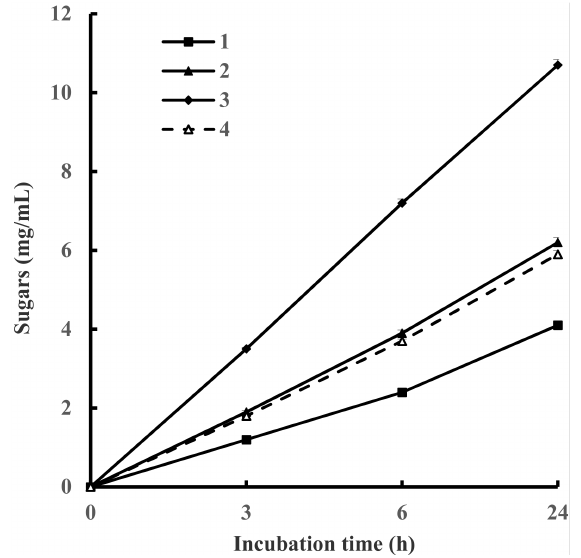
Figure 3. Accumulation of reducing sugars during hydrolysis of pretreated wheat straw (WS) using I. lacteus (1–3) and commercial (4) enzyme preparations. Enzyme load–20 U/g substrate. 1–10 mg WS; 2, 4–20 mg WS; 3–40 mg